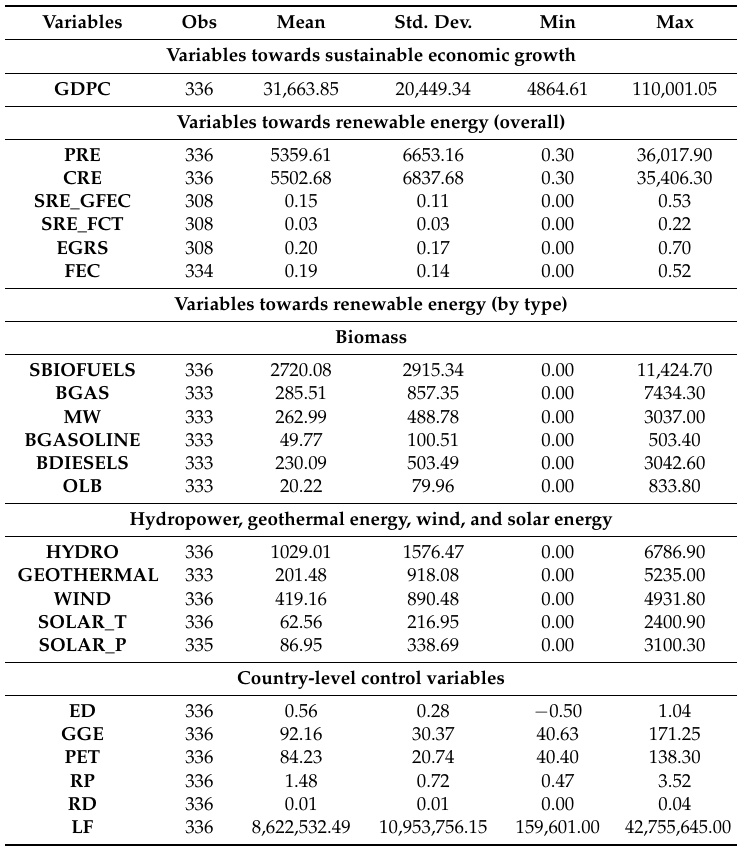
Table 3. Summary statistics of the variables (raw